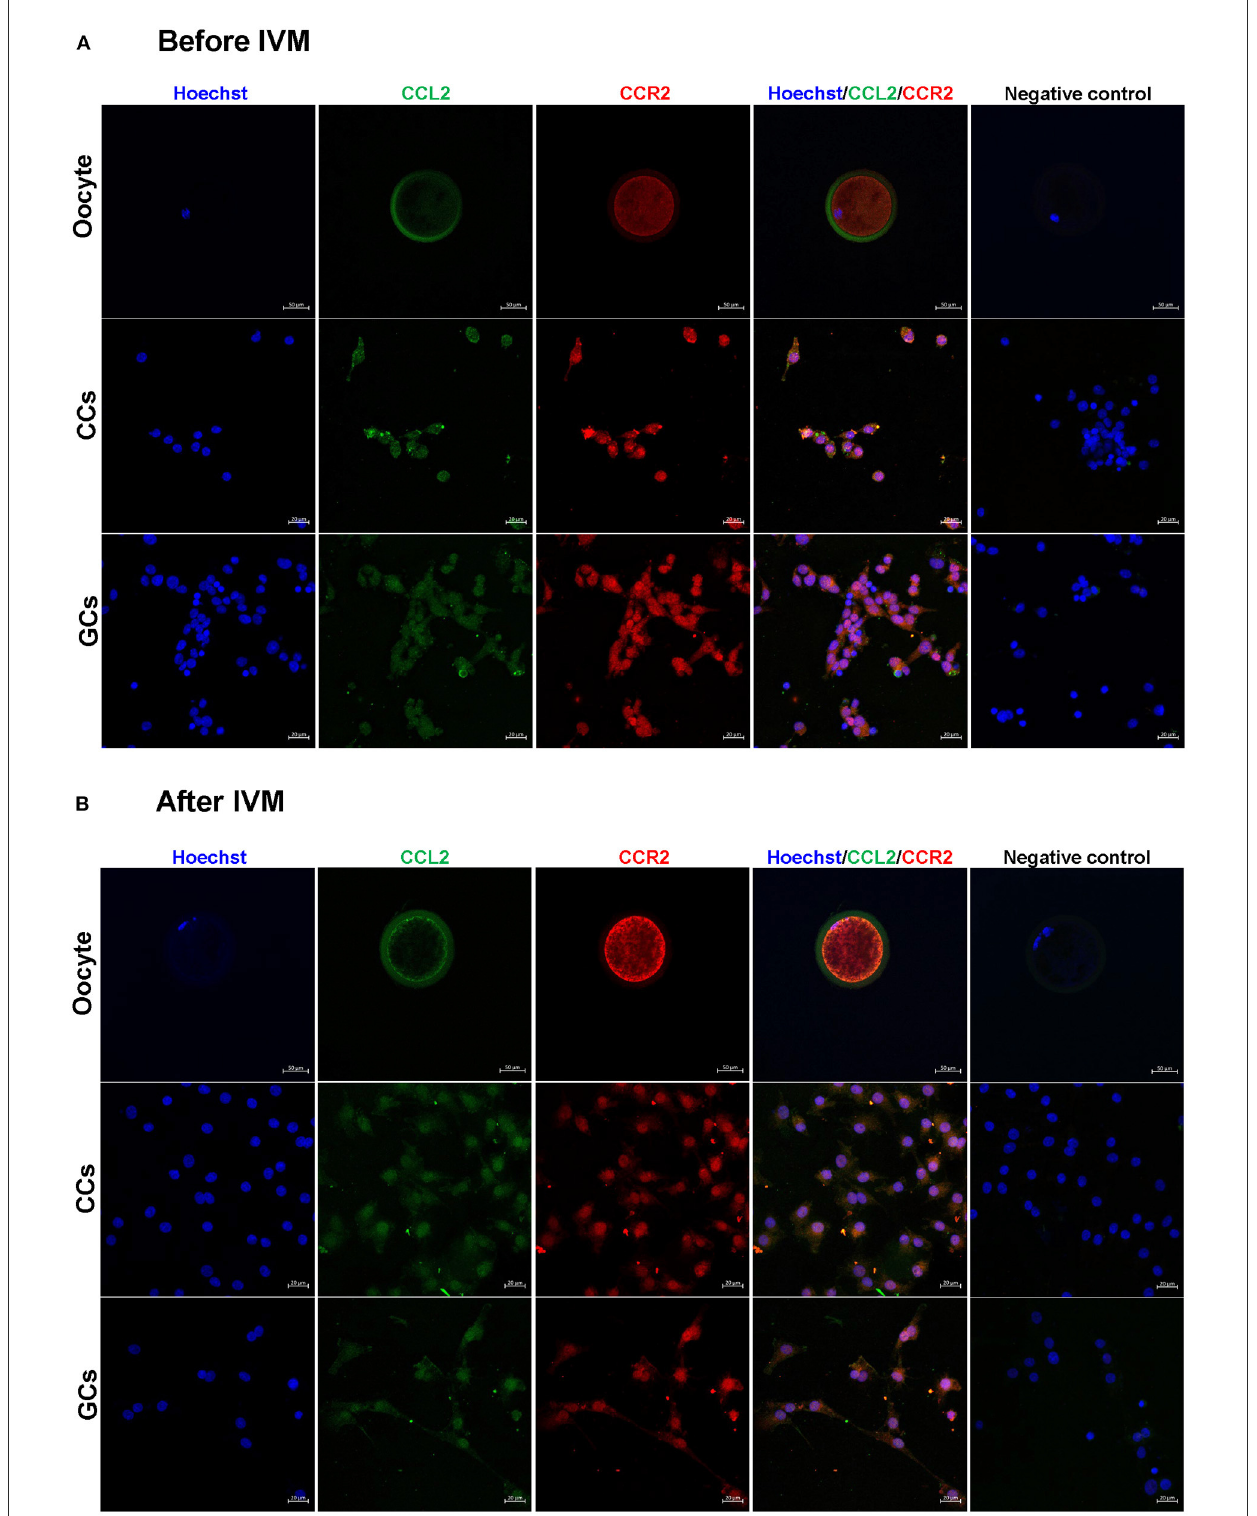
FIGURE2 Detection and localization of CCL2 and its receptor, CCR2, in porcine follicular cells before (A) and after (B) IVM. Blue = Hoechst, green = CCL2, red = CCR2. No staining of CCL2 and CCR2 was observed in the negative control. CCL2 and CCR2 immunostaining was observed in all porcine follicular cells before and after IVM. Scale bar = 20 µ m in oocyte and 50 µ m in CCs and